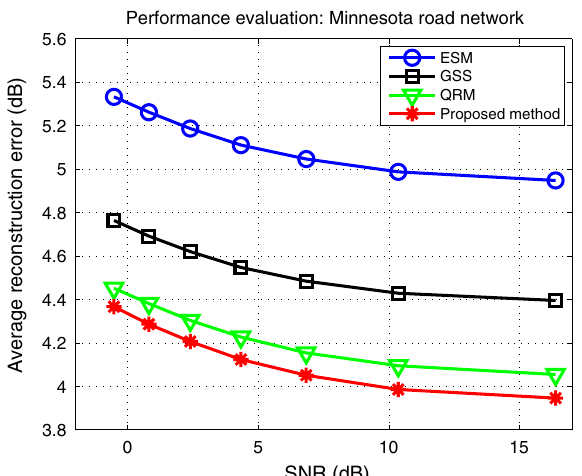
Fig. 9 Performance evaluation for noisy non‑bandlimited graph signals on MRNG with | S | = 50 by varying